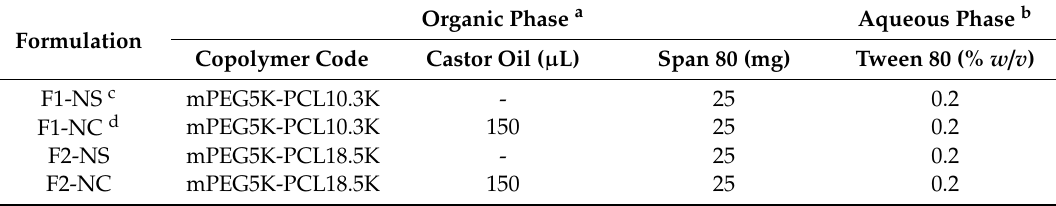
Table 1. Composition of thymoquinone nanoparticles (TQ NPs) prepared in this study.